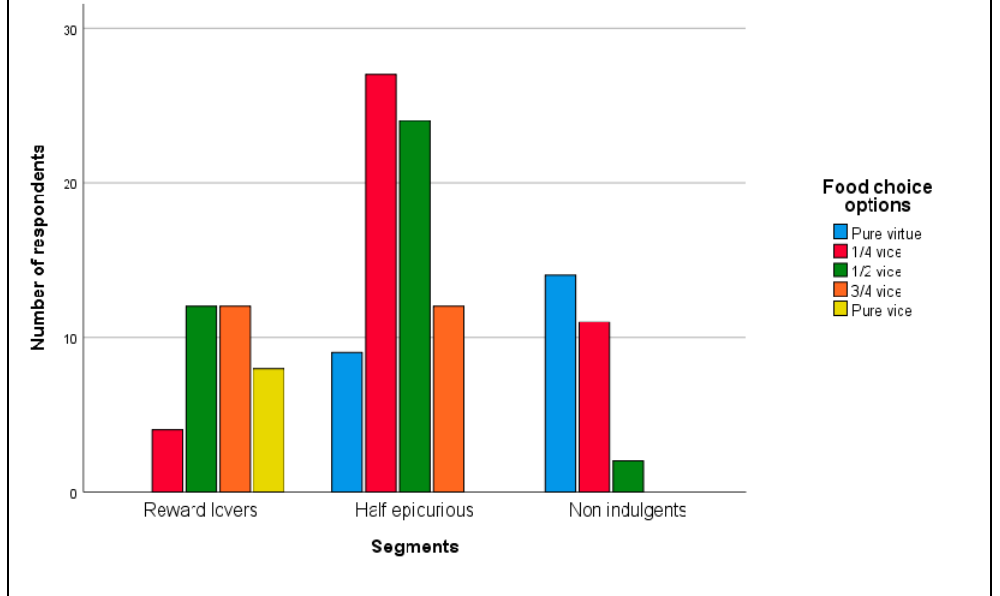
Figure 4. Segment’s food choice. Pure virtue-pure vice set (number of respondents). Nutrients 2020 , 12 , 639